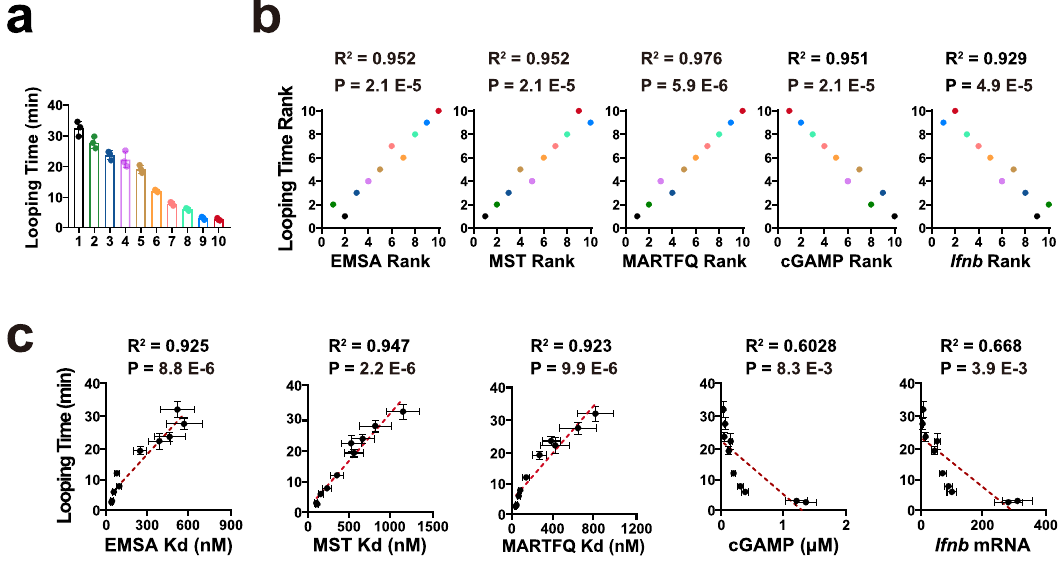
Fig. 3 | DNA fl exibility is associated with DNA potential to bind and activate cGAS. a Looping time of seq1 – 10 ISDs. Mean±SD. n =3 independent experiments. b Spearman analyses of the correlation between the ISD looping time and noted cGAS-binding or -activating potential. P and R values were from two-sided spear- mananalyses. c Pearsonanalysesof the correlationbetweenthe DNAlooping time